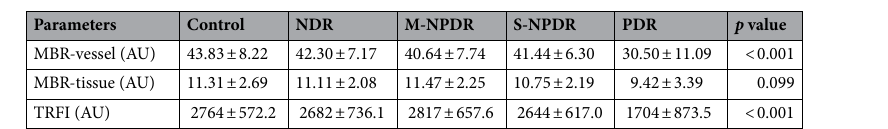
Table 3. Parameters determined by LSFG. AU: arbitrary units, TRFI: total retinal flow index.